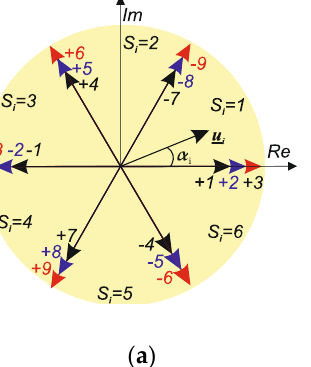
Figure 5. Geometric interpretation of an example vector modulation: ( a ) of input voltage vector,. ( b ) output current vector.